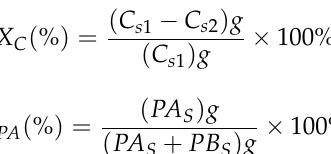
Figure 16. The chemical reaction of ketalization reaction of glycerol with cyclohexanone. The mass of C in the raw material is recorded as C S 1 , and the mass of C in the product is recorded as C S 2 . The mass of PA in the product is recorded as PA S , and the mass of PB in the product is recorded as PB S . The conversion of cyclohexanone( C ) and the selectivity of 1,4-Dioxaspiro[4.5]decane-2-methanol ( PA ) are calculated as